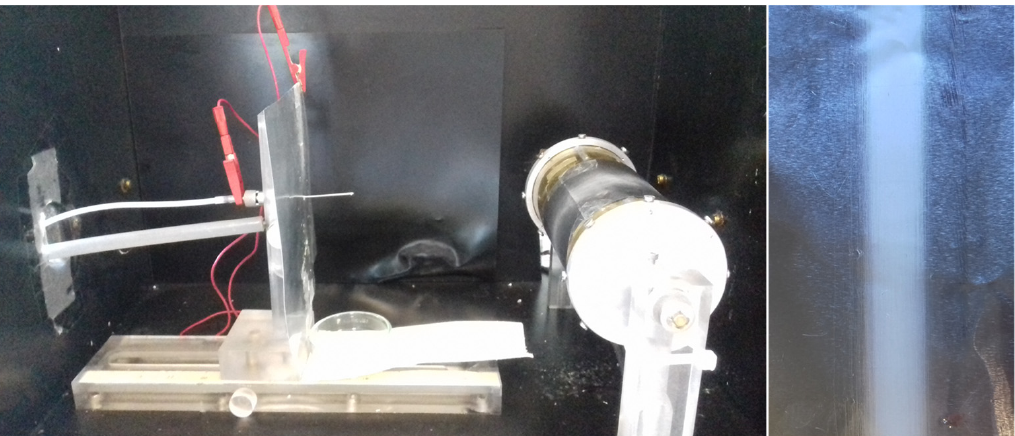
Figure 1. Photographs of the home-made electrospinner equipped used in this study ( left ) and of the one example of the obtained electrospun polymer fibers ( right ).